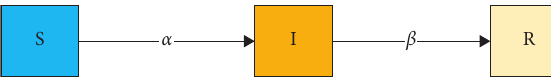
Figure 3: SIR model (source: figure is adapted from Pastor- Satorras et al.